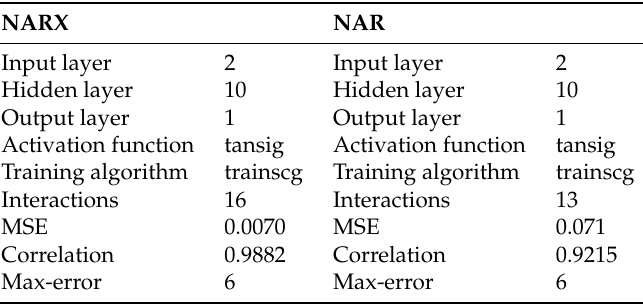
Table 3. Models NARX and NAR: scaled conjugate